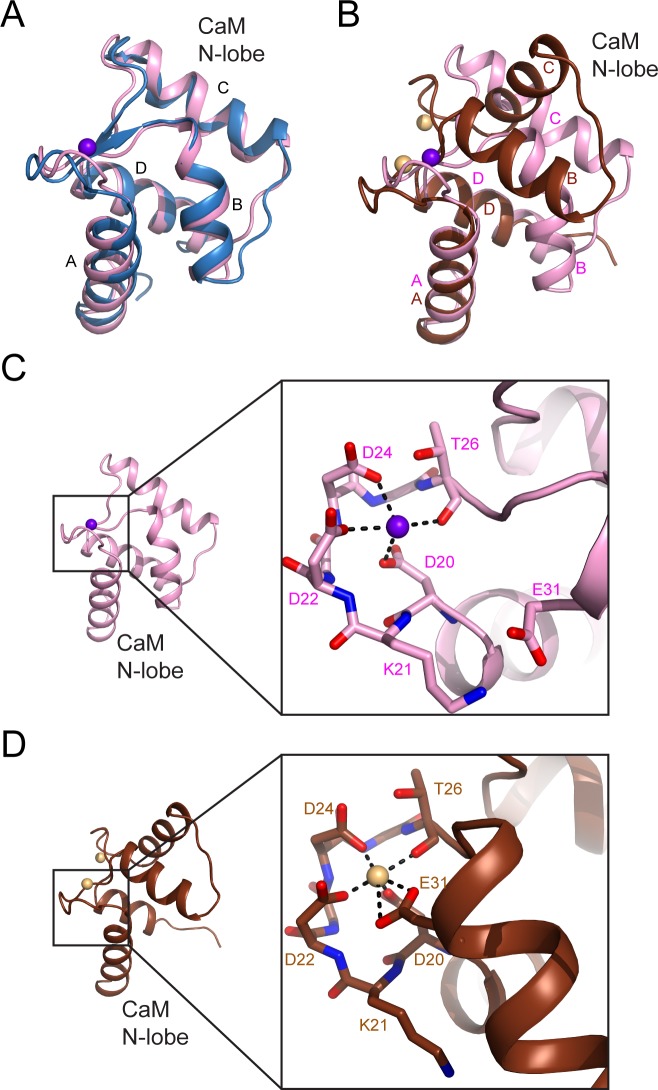
The N-lobe of the CaM in the SidJ–CaM complex adopts a closed conformation.(A) A structural comparison of the CaM N-lobe in the SidJ–CaM complex (pink) with that in apo-CaM (blue) (PDB ID: 1CFC). (B) A structural comparison of the CaM N-lobe in the SidJ–CaM complex (pink) with that in Ca2+ chelated CaM (brown) (PDB ID: 1CDL). (C) The CaM N-lobe in the SidJ–CaM complex is weakly bound by a Ca2+ ion as it is missing the –Z coordination because of the position of E31 away from the ion-binding site. Thus, the N-lobe maintains a closed conformation. (D) Ca2+ chelating at the same binding site in panel (C) for Ca2+ saturated CaM (PDB ID: 1CDL). E31 is fully engaged in coordination with the bound Ca2+ ion and is responsible for the open conformation of the N-lobe.